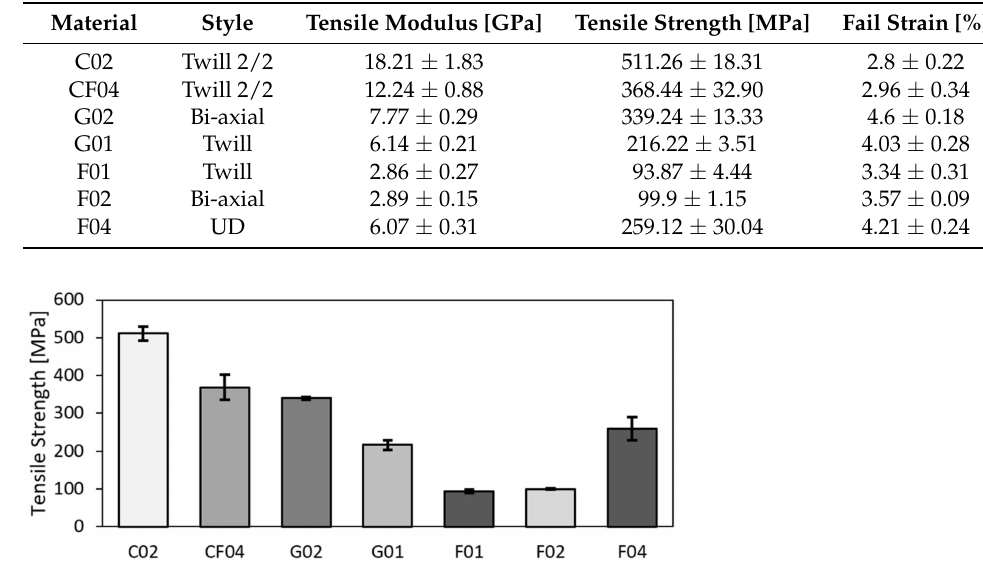
Figure 3. Tensile strengths of test samples.